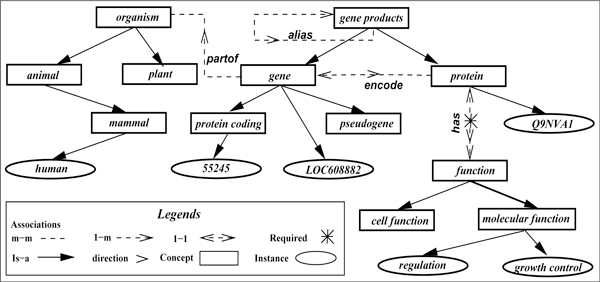
Ontology  O for database Δ in Figure 1.